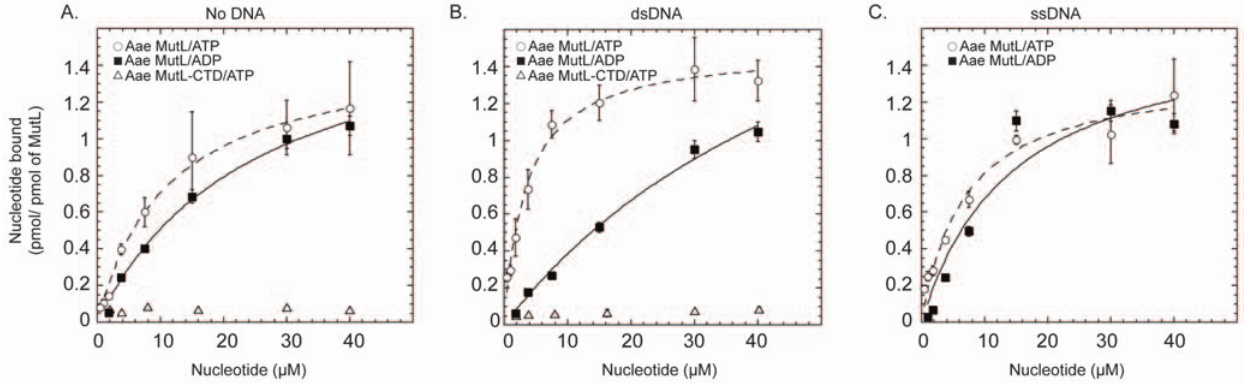
Figure 6. Aae MutL adenine nucleotide binding. The affinity of Aae MutL for different adenine nucleotides was measured by a filter binding assay. The binding of Aae MutL to ATP (open circles) or ADP (solid squares) or of Aae MutL LC20 to ATP (open triangles) was measured. A, nucleotide binding in the presence of dsDNA. B, Influence of ssDNA on full-length Aae MutL nucleotide binding. C, the binding of Aae MutL and Aae MutL LC20 to adenine nucleotides in the absence of added DNA. Each point represents the average of 3 separate